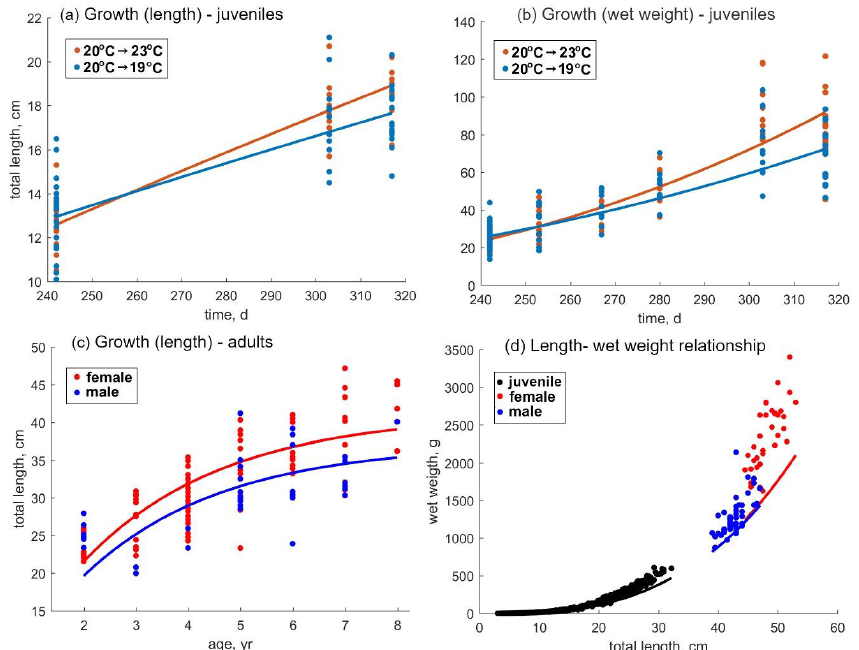
Figure A4. Juvenile and adult growth of S. senegalensis . ( a , b ) juvenile growth in total length and wet weight over time; ( c ): adult (male, female) growth in total length over time; ( d ): length-wet weight relationship for juveniles and adults (male, female). Data sources and corresponding conditions (estimated scaled functional response f , simulated temperature T): Panels ( a , b ): [108] ( f = 1.49, T = 20 °C from birth until start of experiment, 19 °C or 23 °C thereafter); Panel ( c ): [62] ( f = 0.80, T = 17.5 °C); Panel ( d ): [102] ( f = 1).